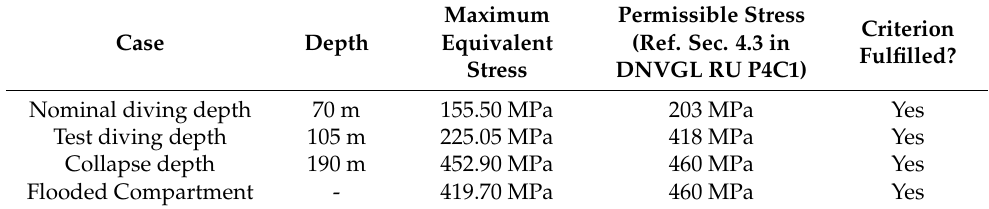
Table A6. Equivalent stresses and permissible stresses for external hull for SST 1: Subsea shuttle tanker (Cargo 10,569 m 3